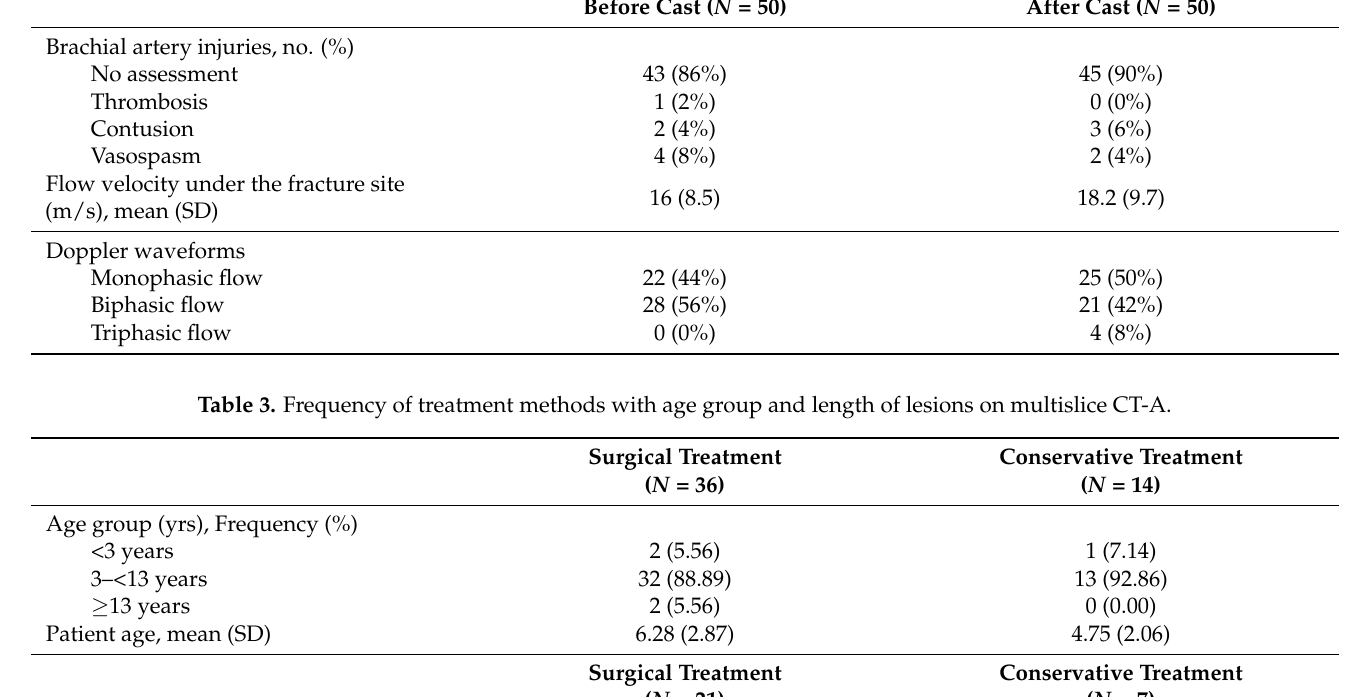
Table 2. Brachial artery injuries and flow velocity around the fracture site with Doppler sonography classification, before and after casting.